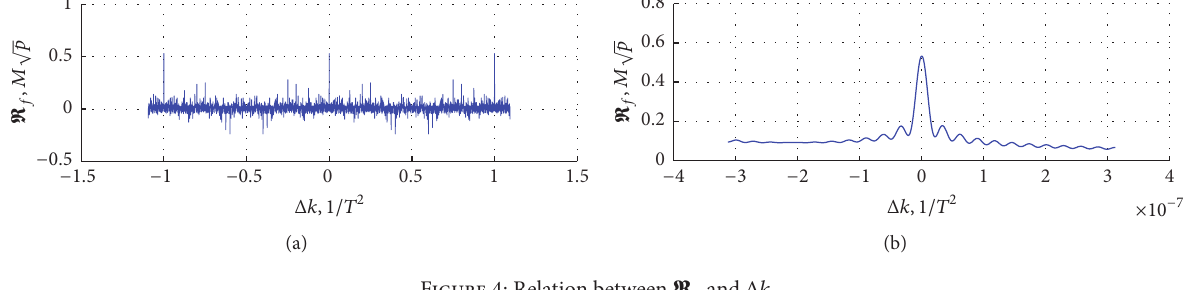
Figure 4: Relation between R 𝑘 and Δ𝑘 .